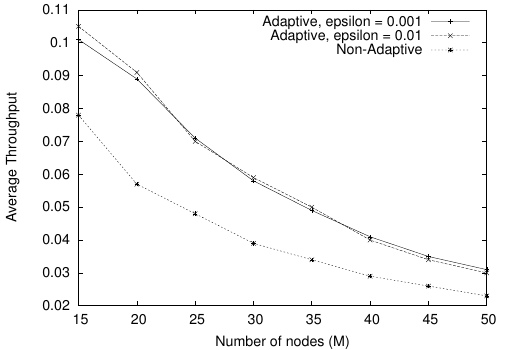
Figure 1: Av. throughput (homogeneous case).